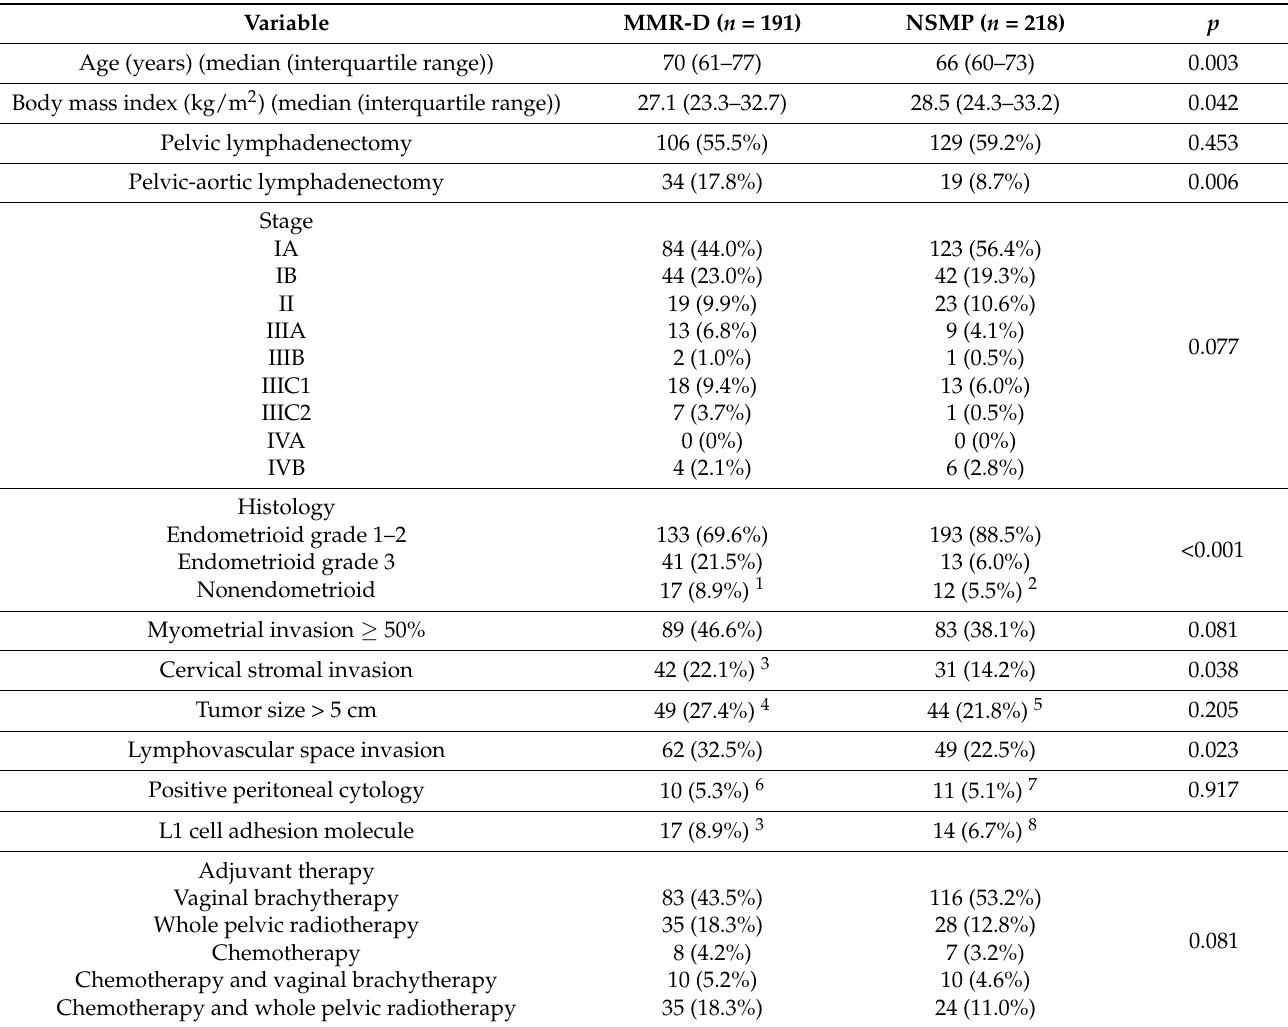
Table 2. Characteristics of the study population according to subgroups based on The Cancer Genome Atlas.